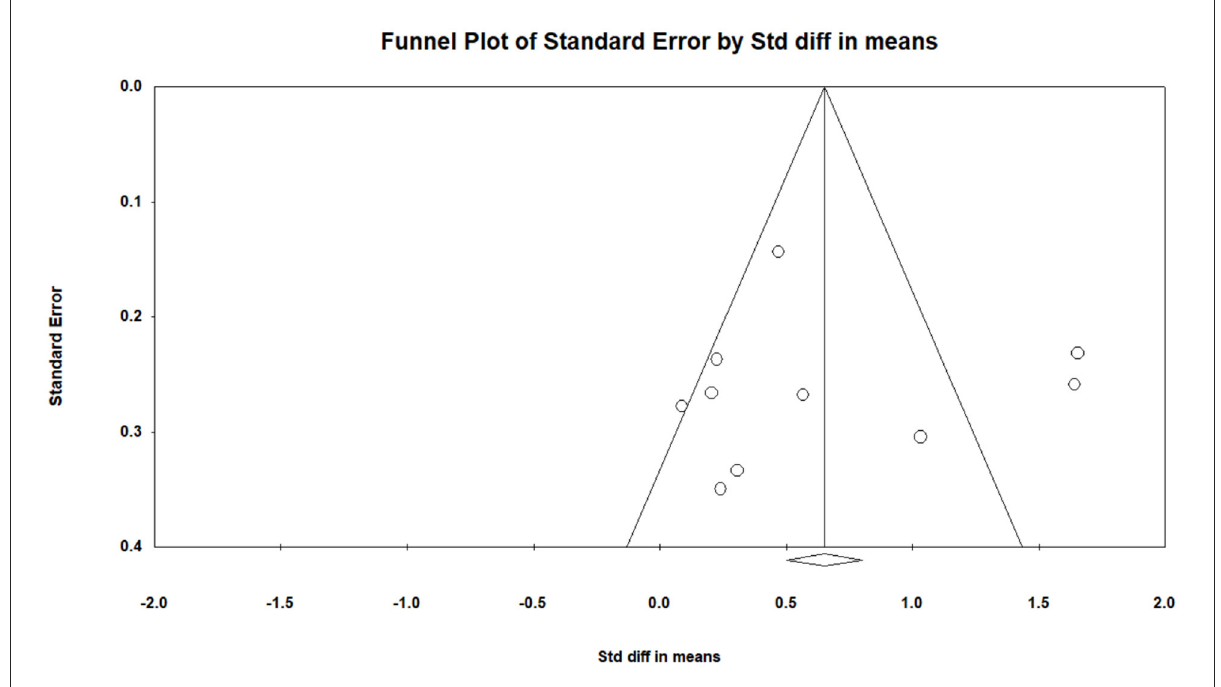
FIGURE3 The funnel plot for publication bias in depression.